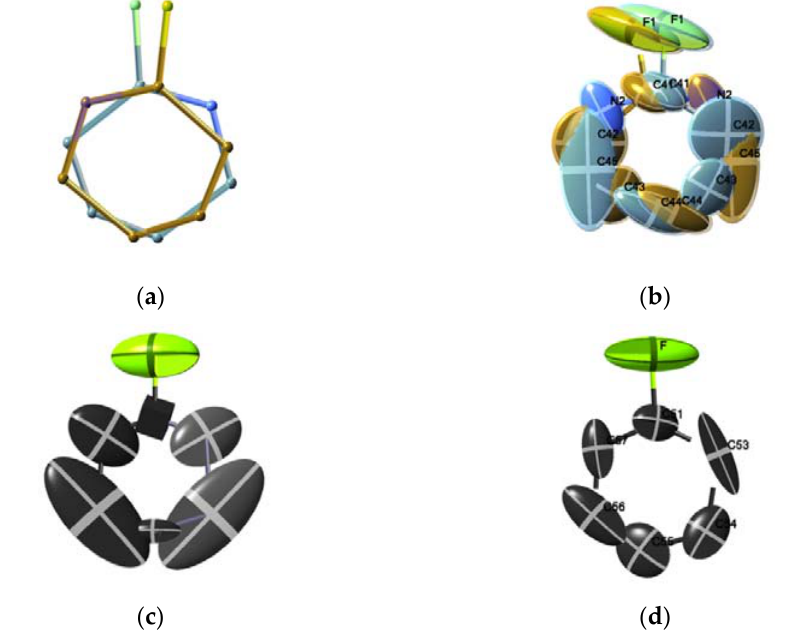
Figure 7. View of 2-FPy molecule in the crystal structure 1 . Wireframe ( a ) and ellipsoid ( b ) views at 240 K ( 1c ), 150 K ( 1b ) ( c ) and 100 K ( 1a ) ( d ). Fluorine and central carbon atoms are placed on lattice twofold axis ( − x , y , 1/2 − z ) at 150 K.